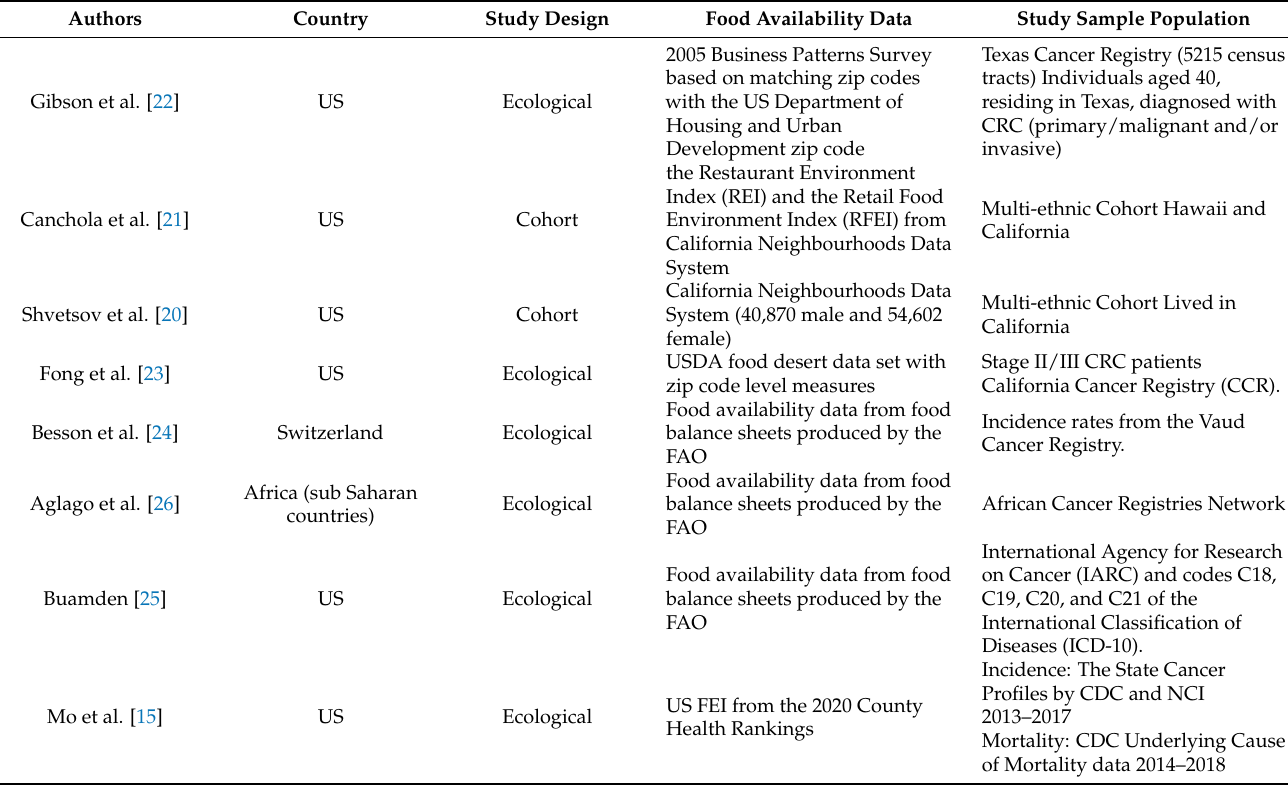
Table 4. Characteristics of the included